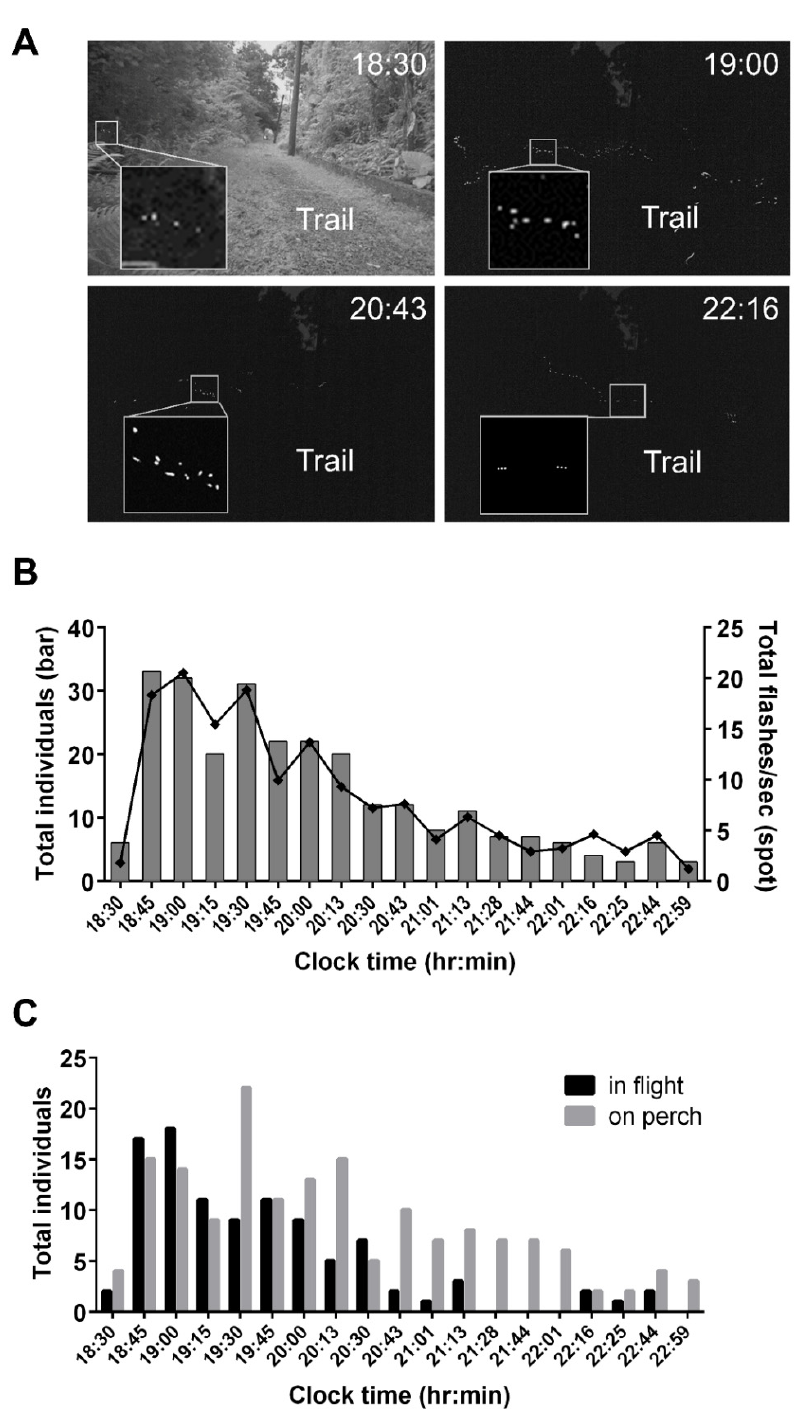
Figure 4. A case study of the nocturnal change in flash patterns and flash activities along the Genliao hiking trail on 21 April 2018. ( A ) Time stacking (10 s) images in grayscale show the change in flash density and flash patterns (inner panels) at 18:30, 19:00, 20:43, and 22:16. ( B ) A time-course bar chart reveals the nightly changes in total flashes/s (black spots) and their corresponding individuals (dark gray bars). ( C ) A time-course bar chart displays the nocturnal change in the number of individuals in flight (black bars) and on perch (gray bars). Both the flashes and individuals in ( B , C ) were recognized from 19 video clips (10 s/clip) recorded during 18:30–23:00. The discrimination of flying and perching individuals in the video followed the methods in Figure 1. Environmental conditions during 18:30–23:00: Temperature: 20.7–22.9 ◦ C; Relative humidity: